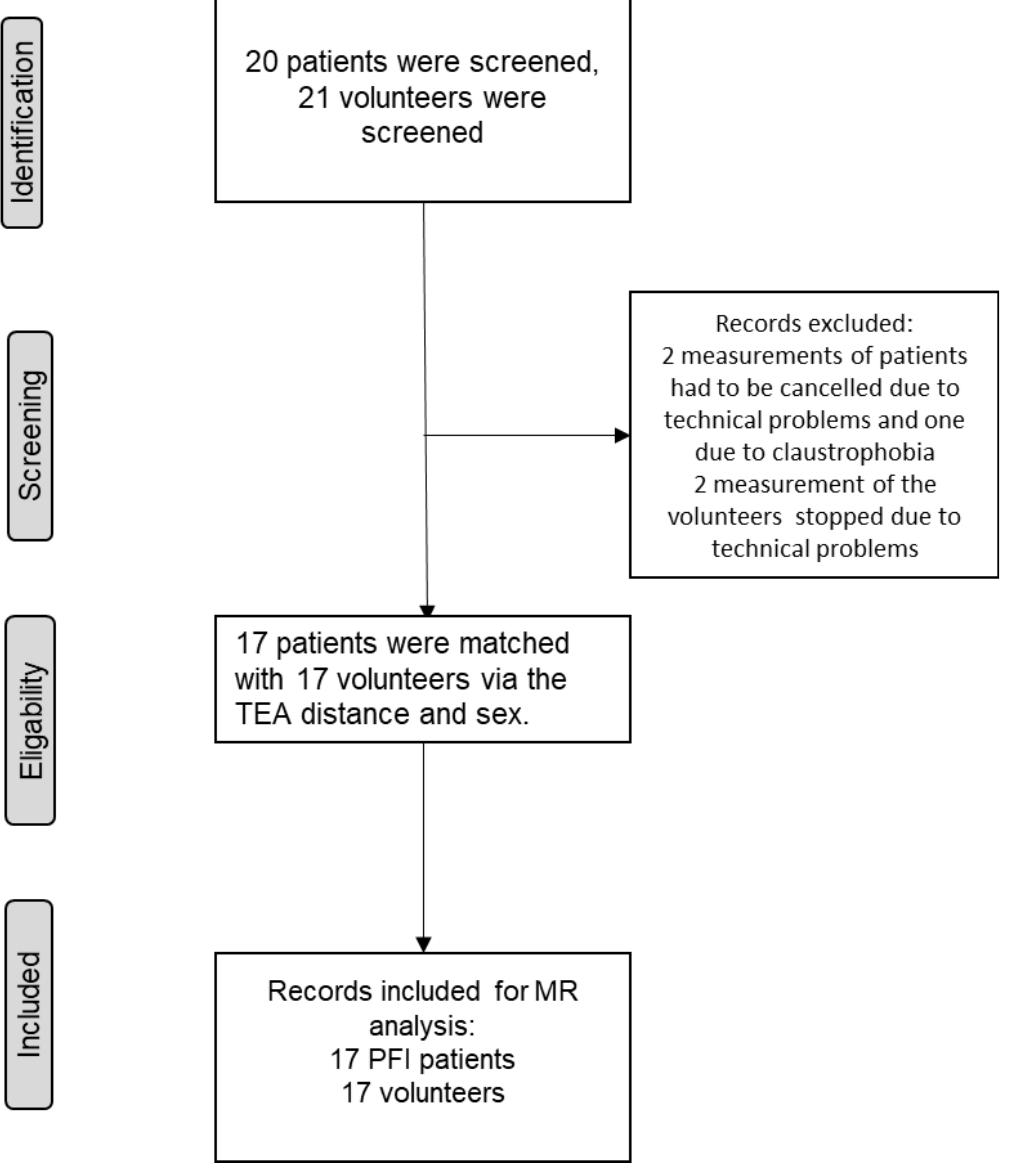
Figure 1. Flow diagram of the selection process according to the STROBE guidelines.